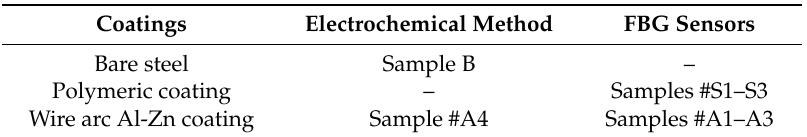
Table 1. Test sample matrix.